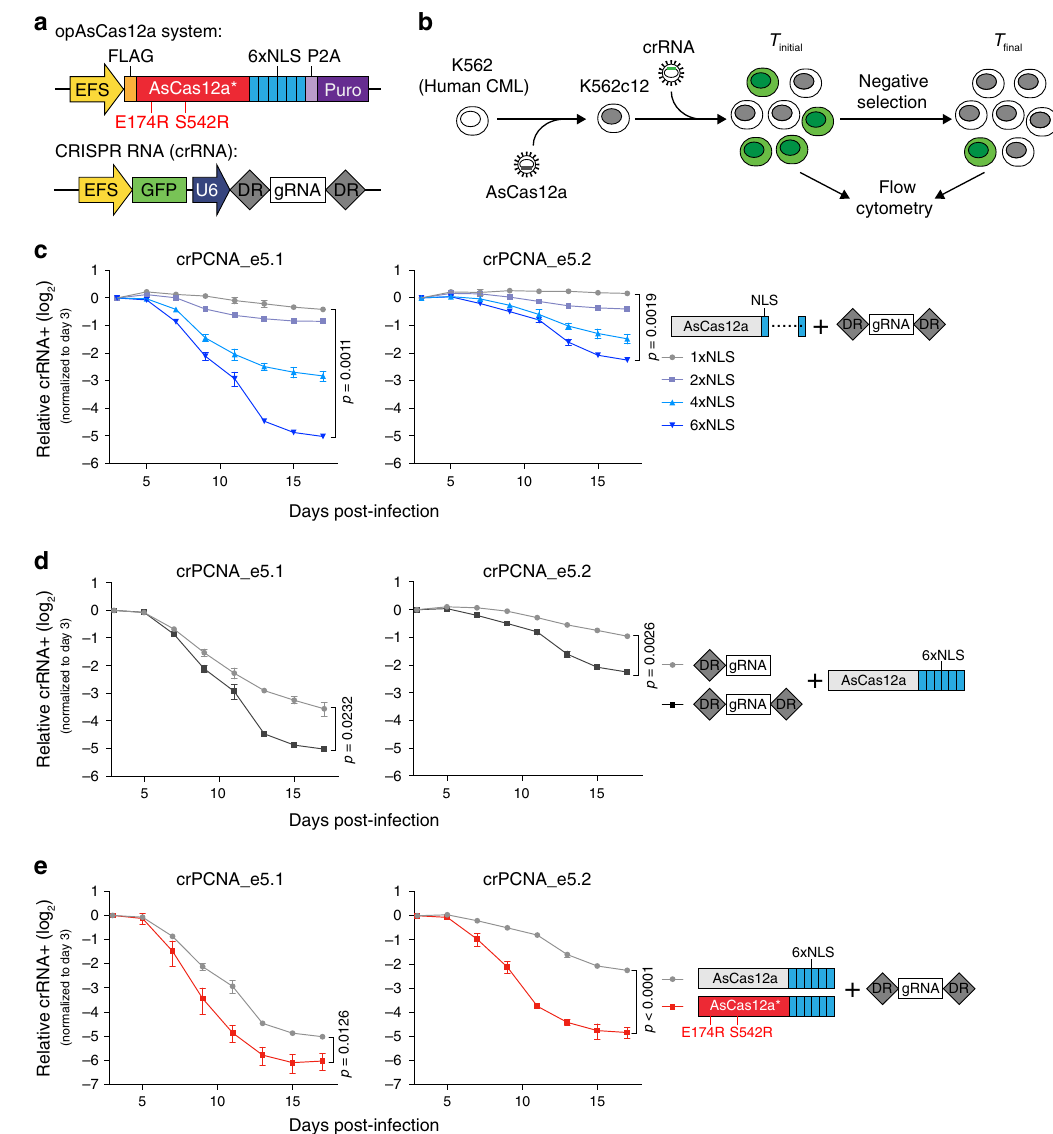
Fig. 1 Optimization of an AsCas12a system to improve knockout ef fi ciency in mammalian cells. a Con fi guration of the optimized vectors used for lentiviral AsCas12a and CRISPR RNA (crRNA) transduction experiments in mammalian cells. A Puromycin (Puro) resistance gene was used to select AsCas12a-positive cells, and a GFP reporter was linked with crRNA expression to track the crRNA-positive population in cellular competition assays. b Experimental work fl ow of cellular competition assay to evaluate AsCas12a knockout ef fi ciency. K562 cells were stably transduced with indicated AsCas12a vector, followed by secondary infection with crRNA virus. Flow cytometry-based tracking of the crRNA-positive cell population over a period of time was used to calculate the negative selection phenotype of each indicated crRNA. Cellular competition assay to compare the knockout ef fi ciency of the AsCas12a system with a variable number of NLS sequences ( c ), with or without an additional direct repeat (DR) 3 ′ of the crRNA ( d ), and with an AsCas12a variant (E174R and S542R) ( e ). Plotted are the crRNA-positive cells (normalized to the day 3 measurement) at the indicated timepoints during culturing. Two crRNAs were designed targeting PCNA , an essential gene for DNA replication. “ e ” represents the exon. ( n = 3). p values are indicated (two-tailed Welch ’ s unpaired t -test). Error bars smaller than symbol width not shown. All error bars shown represent mean ± SD. Source data are provided as a Source Data fi le. quantify each domain ’ s essentiality in supporting cancer cell AsCas12a CSs demonstrated lower precision between replicate proliferation (Fig. 2a). Spike-in positive and negative control screens ( r = 0.85) than either opAsCas12a or SpCas9 and did not CRISPR RNAs included in the libraries validated the overall correlate as well with SpCas9 CSs ( r = 0.81) (Supplementary accuracy of all three pooled screens (Supplementary Figs. 10 and Fig. 9). Notably, all three screens revealed all known drug targets 11). At the level of individual CRISPR RNA, LFCs of opAsCas12a and dependencies in this murine Mll-Af9 leukemia model 18 – 26 (Fig. 2d, e and Supplementary Fig. 9). Collectively, these data screens were highly correlated between biological replicates ( r = highlight the strength of a domain-focused analysis of protein- 0.87) and suggested similar robustness to the SpCas9 screen data coding gene function and support our conclusion that our ( r = 0.89). At the protein domain level, CSs of opAsCas12a opAsCas12a system performs with similar robustness to SpCas9 screens were highly correlated between biological replicates ( r = in single-gene dropout screening. 0.96) and with the SpCas9 screen data ( r = 0.93) (Fig. 2d, e). WT NATURE COMMUNICATIONS| (2020) 11:3455